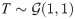
Pattern of prediction errors depends on the nature of communication between actor and critic.In each case (A–C), we consider signals for three particular times of T at which the critic receives notice of the impending lever press: 1 s (blue), 3 s (red), and 10 s (green). Parts of the signal where there is overlap between two or more different times of T are plotted in black. In each case, we plot TD errors (top), TD errors convolved with symmetric kernel (middle), and TD errors convolved with ‘asymmetric’ kernel (bottom). (A) Indirect communication (a′′) only, T∼G(1,1). (B) Indirect communication (a′′) only, T∼G(2,1). (C) Both direct and indirect communication (a′; a′′), T∼G(2,1), with timing uncertainty (uncertainty scaling constant k = 0.1). Vertical dashed lines indicate times of observable events, i.e. cue presentation (t = 0, black) and lever presses (t = T+τ
post, coloured). Note the difference in y-axis scaling between (A;B) and (C). Model parameters: a = −1, b = 0, r = 1, τ
post = 0.5 s, τ
I = 30 s.